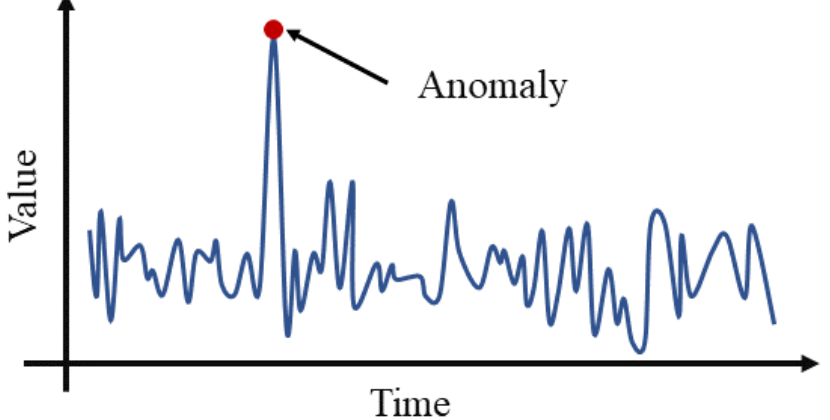
Figure 3. Point anomaly detection.